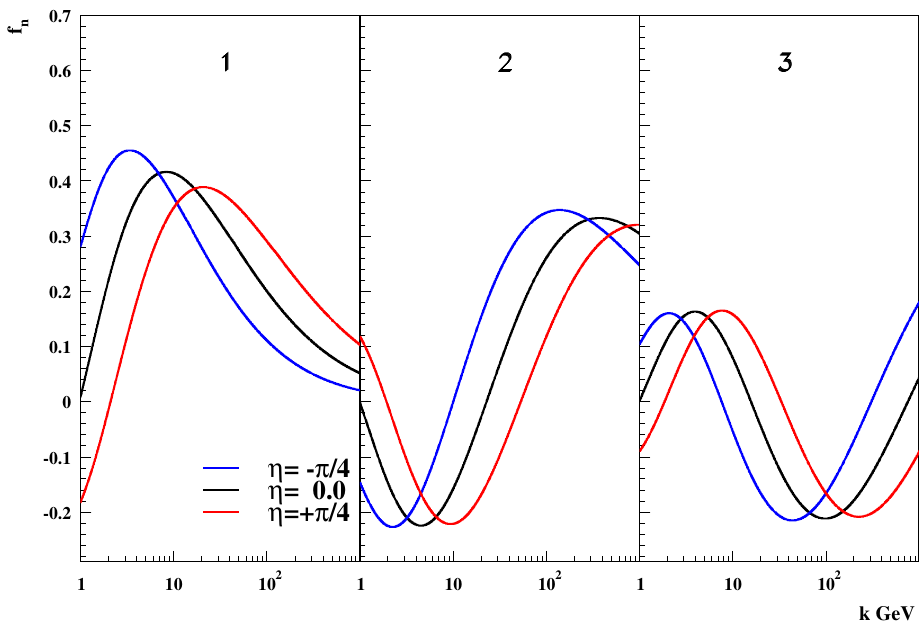
Fig. 4 The first three eigenfunctions computed for three fixed non-perturbative phases, η